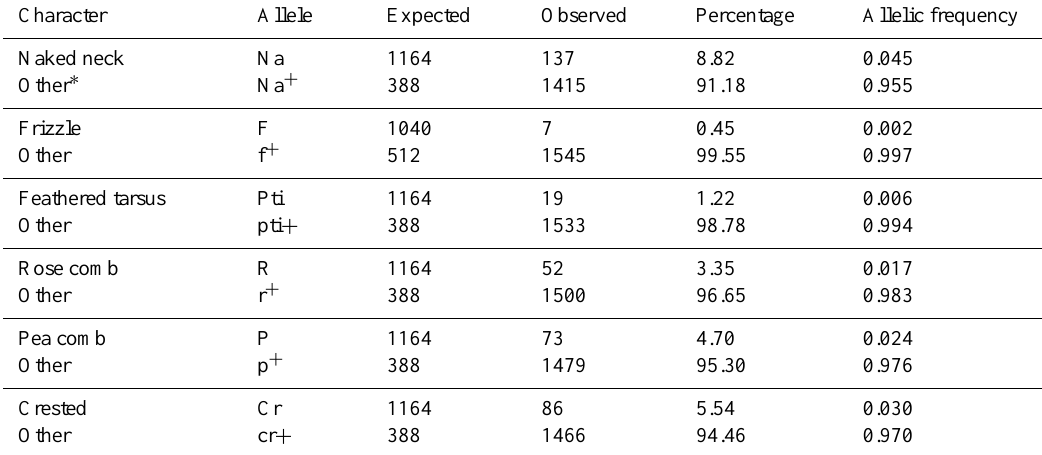
Table 3. Percentages (%) and allelic frequencies of visible genes from 1552 local chickens in the northwest of Algeria. Character